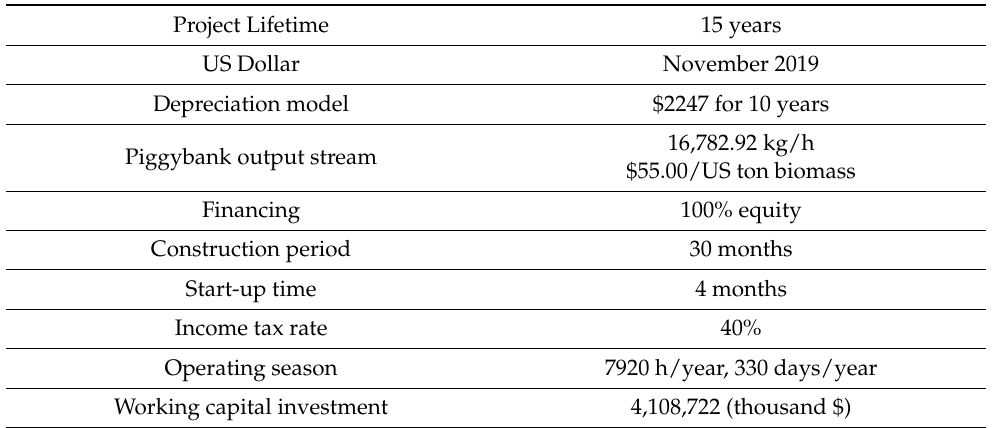
Table 3. Assumptions associated with the current process design.